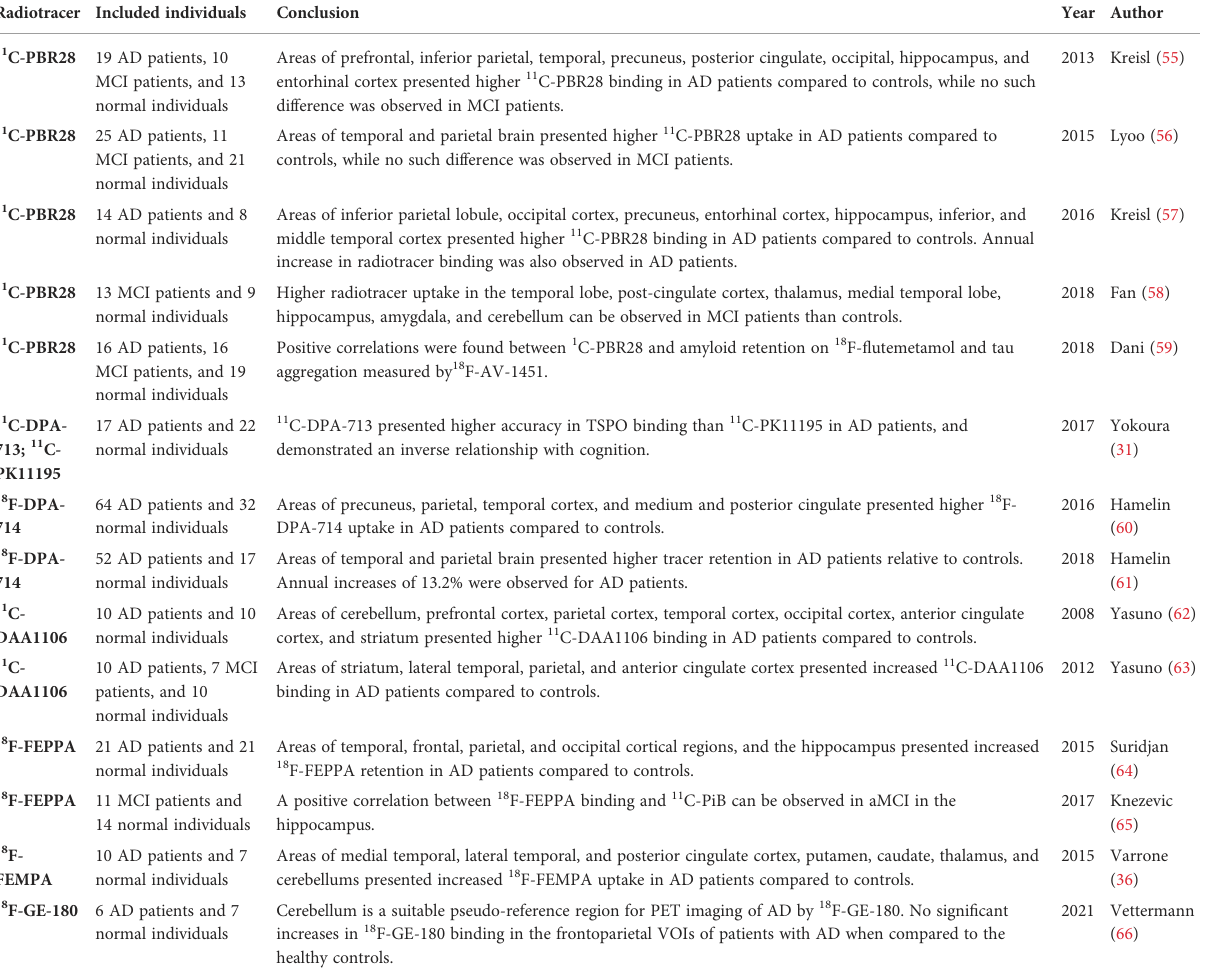
TABLE 2 Studies examining regional brain uptake via advanced TSPO tracers in AD and MCI. Radiotracer Included